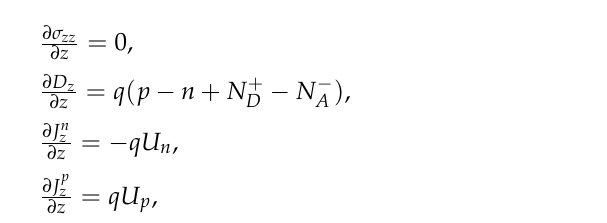
Figure 2. The physical model of ultraviolet irradiation on a GaN nanowire. For a 1-D PSC with the polarization direction along the z -axis, the constitutive equa- tion in Cartesian coordinates can be written as [31 – 34] 333333op t 333333op t 3333 3333